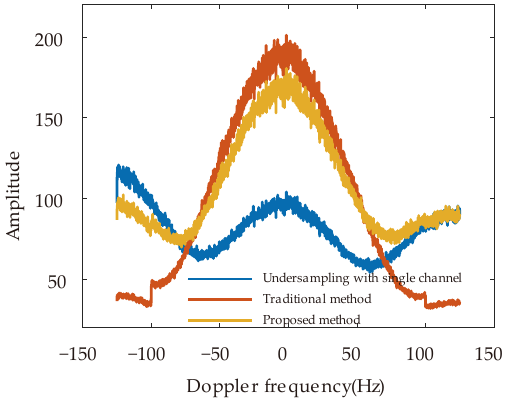
Figure 15. Azimuth spectrum comparison.